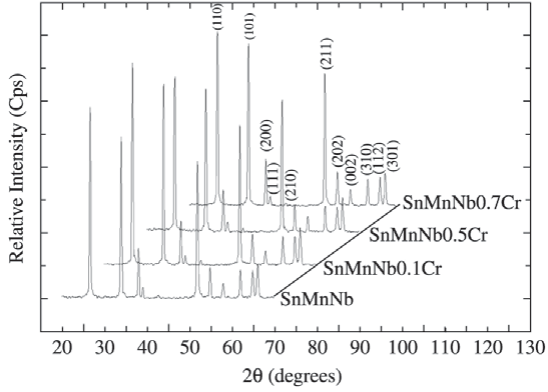
Figure 2. X-ray diffraction patterns of powders prepared by mix- ture of Table 1. Molar system composition and nomenclature used for each system (Pch indicate Pechini method and Mox, mixture of oxides). Composition of System